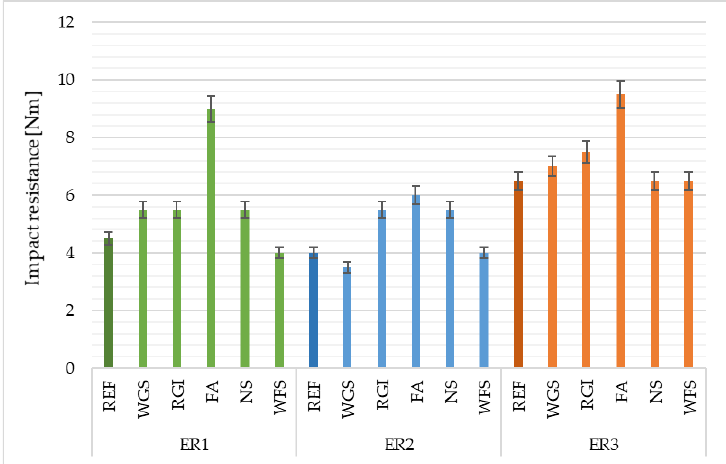
Figure 10. Impact resistance of epoxy composites depending on the type of filler and epoxy binder used.